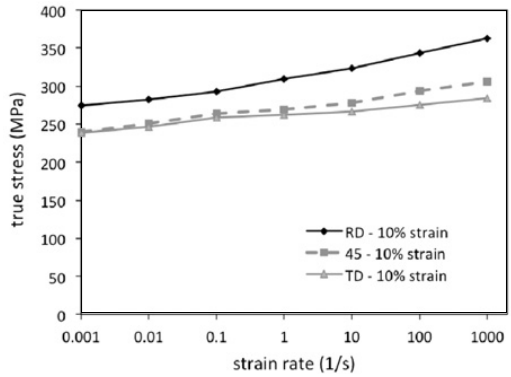
Fig. 15. True stress vs. strain rate for ZEK100 sheet in the RD, TD and 45 ◦ orientation at 10%